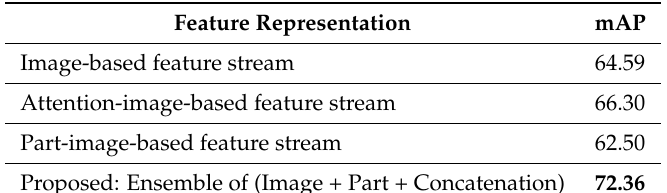
Table 5. Comparison of mAP obtained through feature representation from multiple streams for action recognition on the V-COCO Dataset [16]. Bold font indicates the best